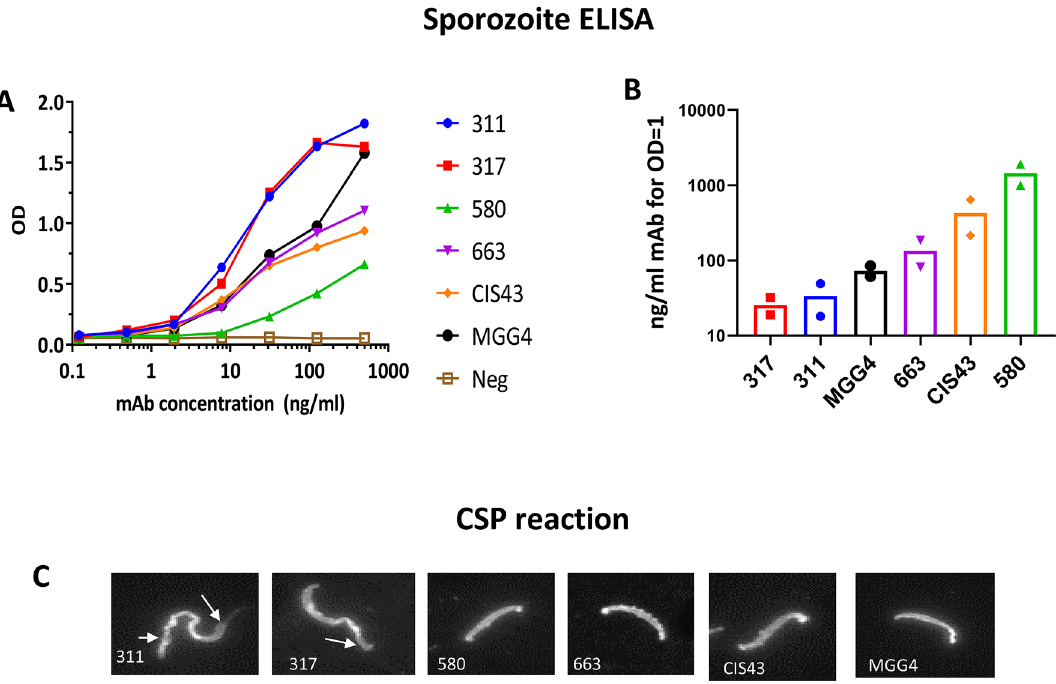
Figure 8. MAb reactivity to sporozoite. ( A ) ELISA curves of mAbs binding to transgenic P. berghei sporozoites carrying the P. falciparum CSP gene. ( B ) Mean ng/ml that resulted in OD = 1 for the sporozoite ELISA. Data from two independent experiments are shown as symbols. ( C ) Representative CSP reaction assay at 100 ng/ml mAb, performed twice using live transgenic P. berghei sporozoites carrying a functional P. falciparum CSP gene. Arrows indicate a typical tail-like CSP reaction at the ends of sporozoites.